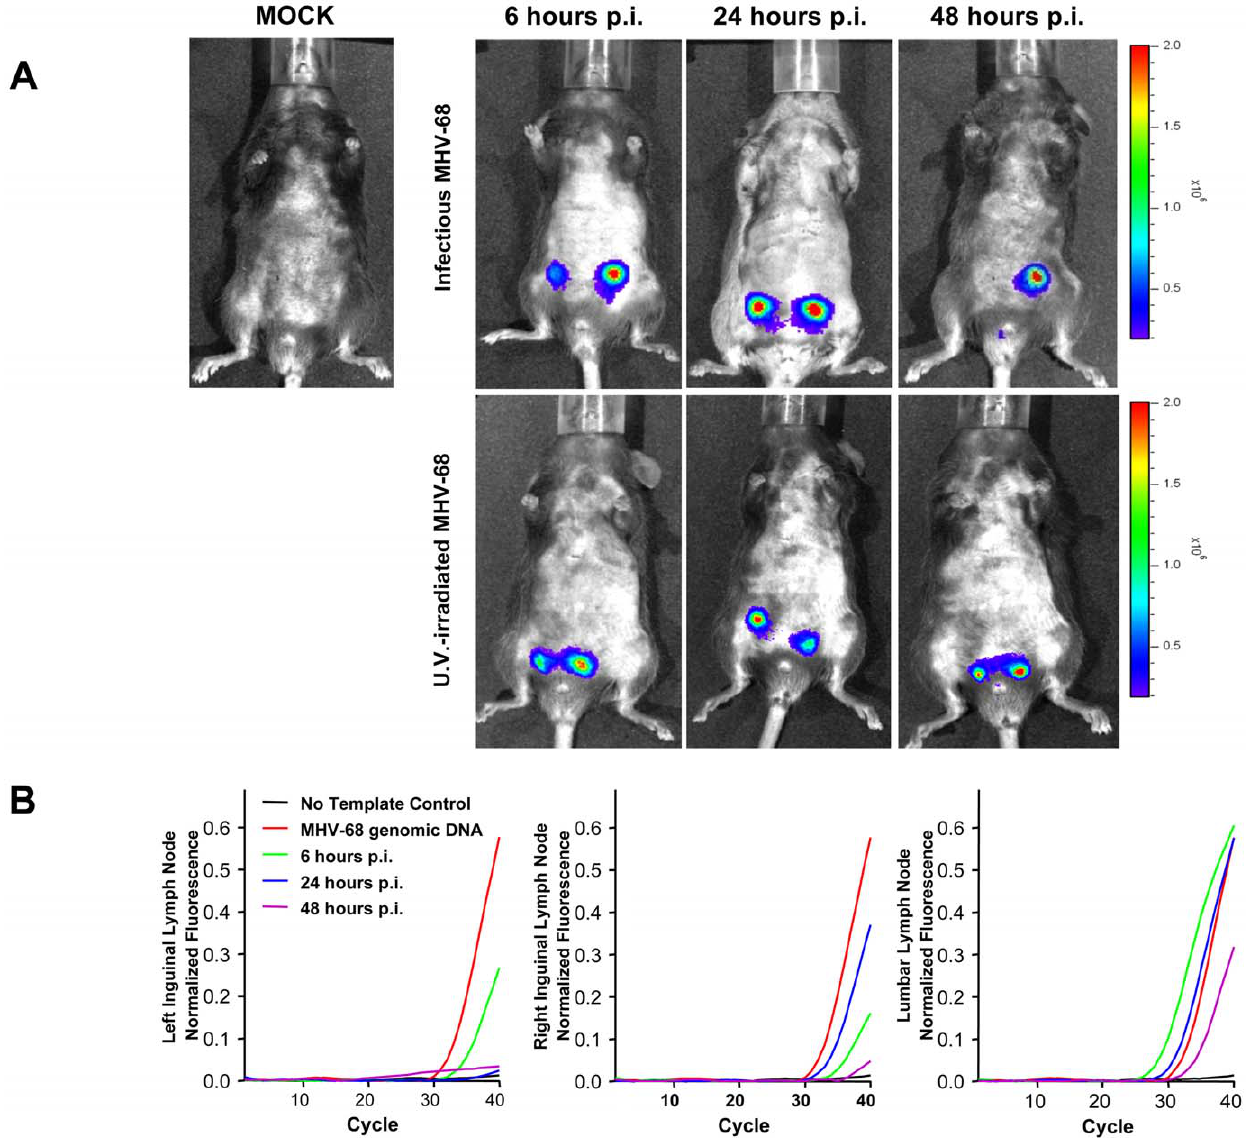
Figure 3. TLR2 transcription is upregulated during MHV-68 infection. ( A ) Bioluminescence assay of TLR2-LUC-AcGFP transgenic mice injected ip. with mock control, infectious MHV-68 or UV-irradiated MHV-68 for 6 hours, 24 hours and 48 hours. ( B ) Quantitative PCR of MHV-68 gB sequence from DNA extraction of inguinal and lumbar lymph nodes of mice infected with infectious MHV-68. MHV-68 genomic DNA was used as a positive control. Data are representative of three different experiments. p.i.: post-infection.